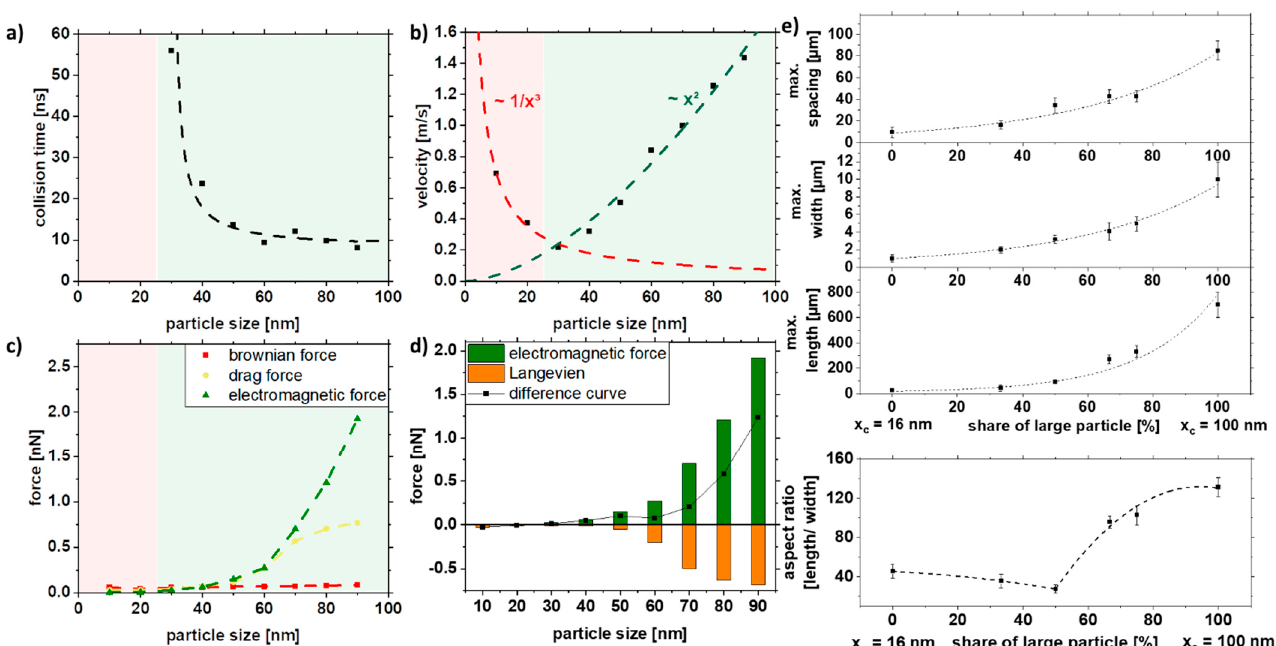
Figure 6. COMSOL simulation data of ( a ) collision time, ( b ) velocity, and ( c , d ) acting forces in dependence of the particle size and experimental validation of ( e ) length, width, spacing, and aspect ratio of strands as a function of particle size distribution in a 5% PMMA solution.